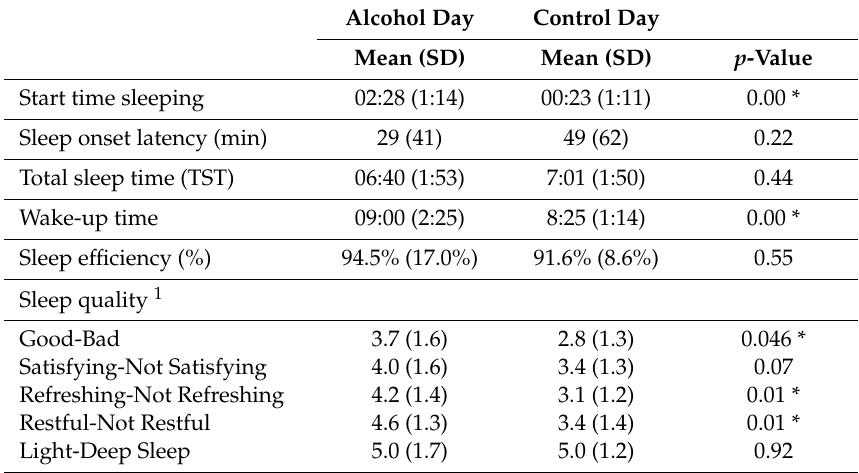
Table 3. Self-reported sleep